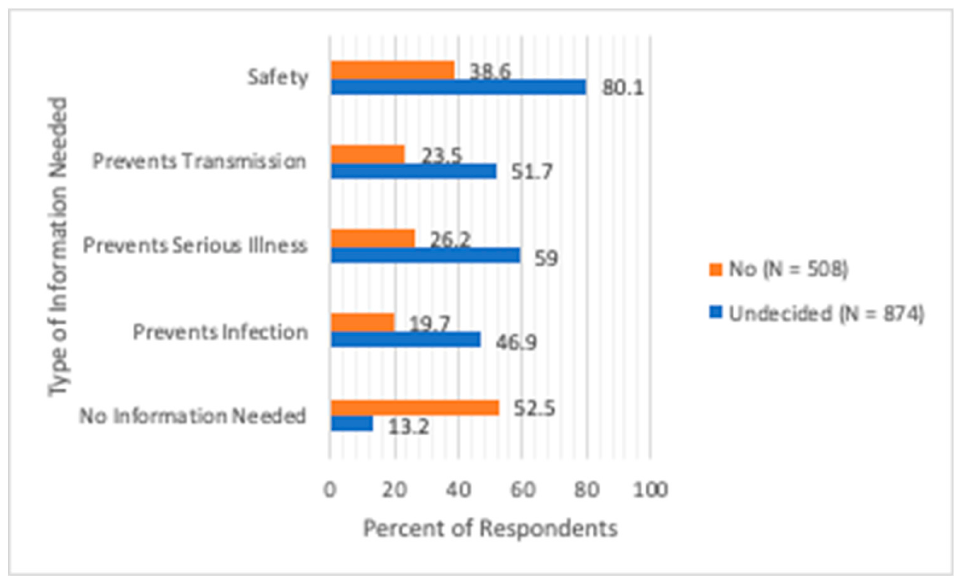
Figure 2. Percentages of undecided parents and parents not intending to vaccinate for whom additional information would influence their decision to have their child vaccinated for COVID-19. Table 3. Percentages of parents endorsing factors that informed a decision to have their children attend in-person class or childcare stratified by intention to